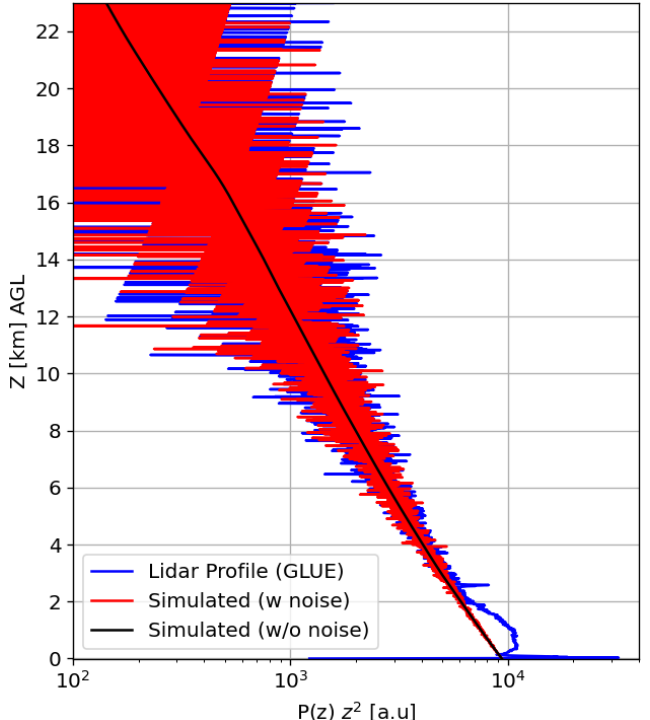
Figure 2. Vertical profiles of the range-corrected lidar signals are shown for a single 30s measurement at 21:00h LT on 14 September 2014 (blue), the simulated molecular signal with noise (red) and the molecular reference without noise (black). The reference was calibrated from 16 to 26km using the average of all 30s measurements from 21:00 to 22:00h LT. The measured photon-counting and analog signals were glued and corrected for the instrument overlap. The signal shows aerosols in the PBL below